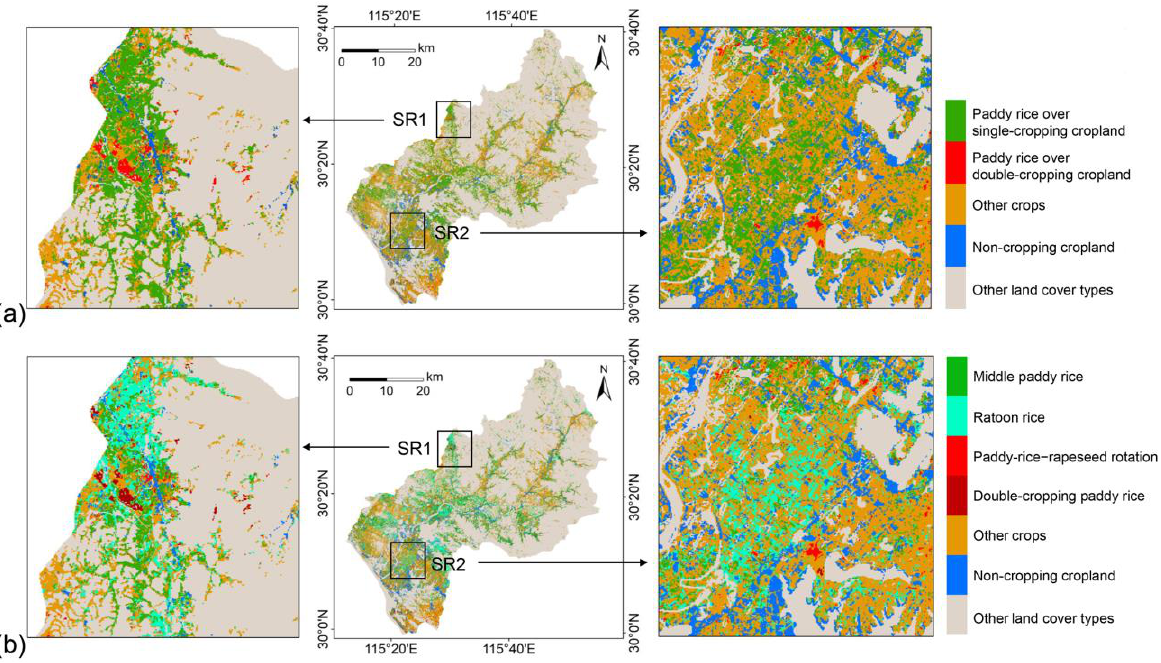
Figure 11. ( a ) Cropping intensity map of paddy rice and ( b ) diverse PRCPs with two sub-regions (SR) for details in the study area in 2019.